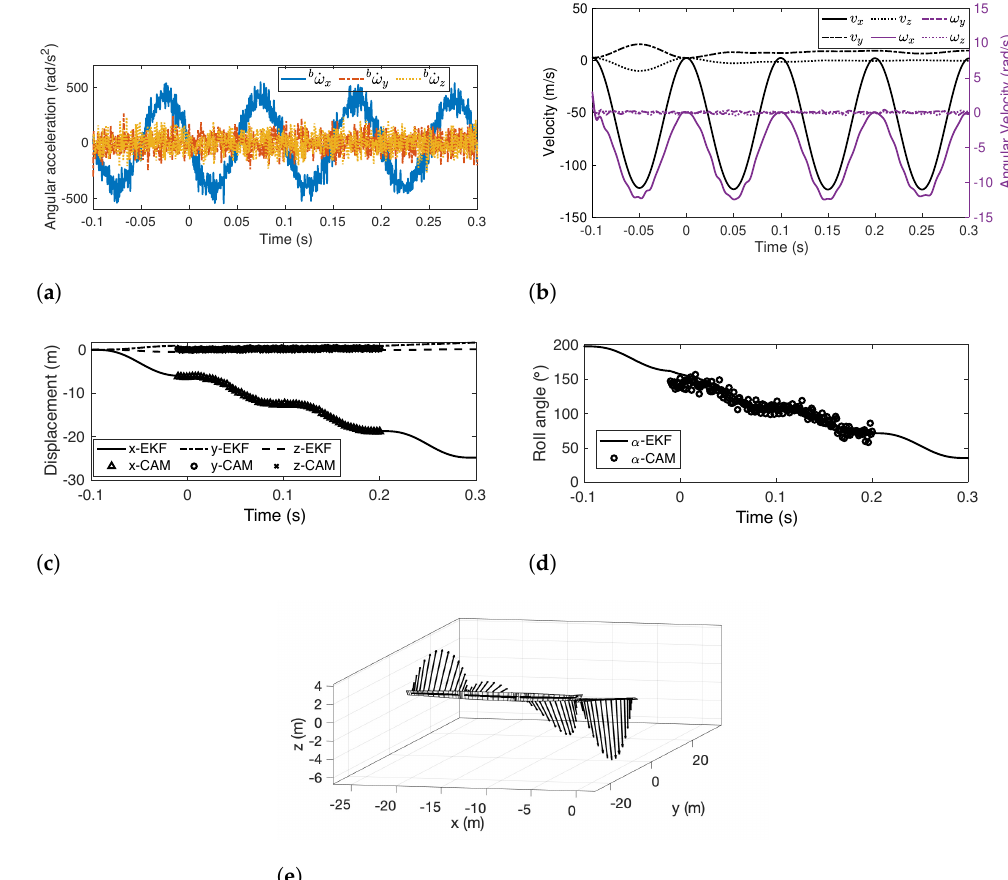
Figure 7. Results of sensor suite localization using EKF framework in a simulated environment. ( a ) Angular acceleration; ( b ) linear and angular velocity of the camera fixture; ( c ) Estimated displace- ment of the camera fixture; ( d ) estimated roll angle of the camera fixture; ( e ) trajectory of the camera fixture in space.